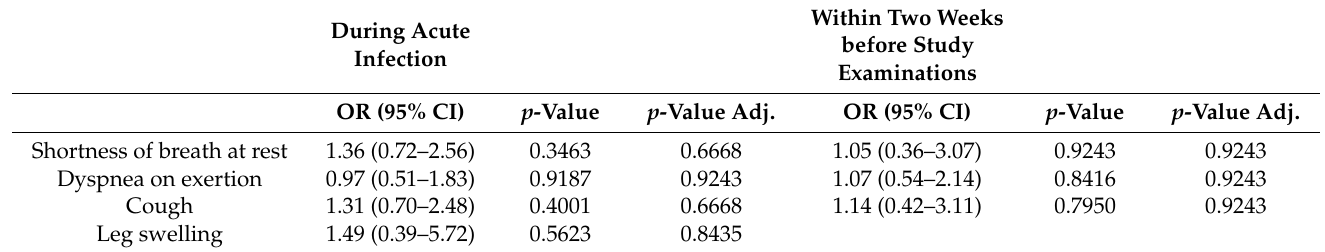
Table 4. Association between selected symptoms/complaints and elevated plasma D-dimer levels (subjects with a diagnosis of venous thromboembolism before the COVID-19 disease were excluded). During Acute Infection